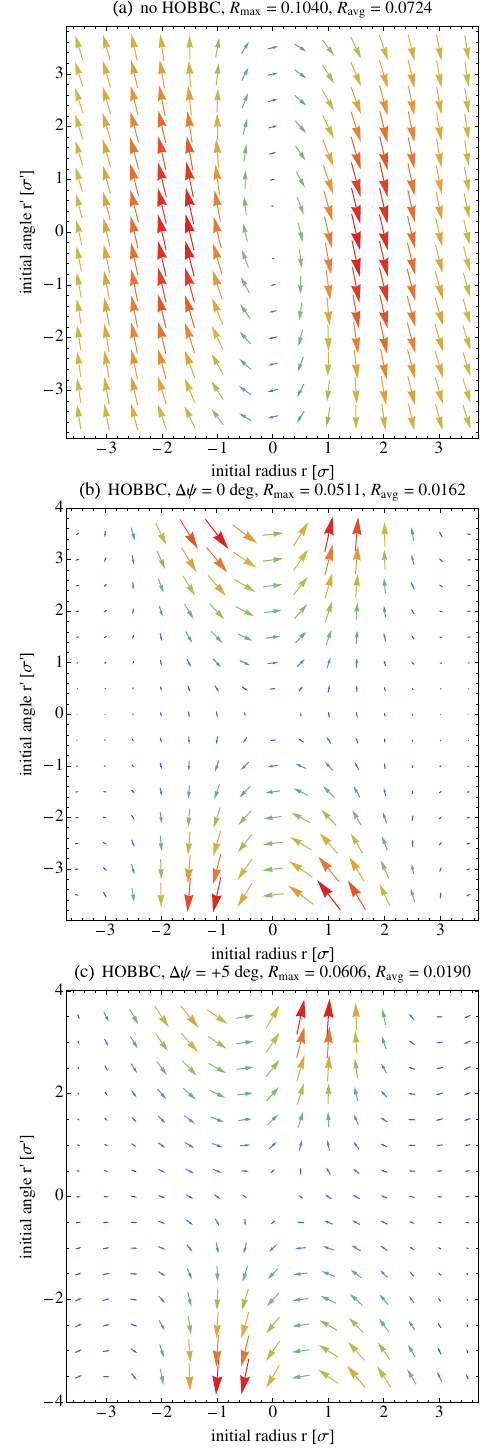
⃗ R FIG. 7. Phase space vector at IP10 as a function of the Þ at IP8 without head-on beam-beam ; r 0 initial coordinates ð r i i compensation in part (a), and deviation from full compensation in part (b) and (c). Part (b) shows the case of a matched electron beam size and current, part (c) has an additional linear phase error of þ 5 deg between the p þ p and p þ e